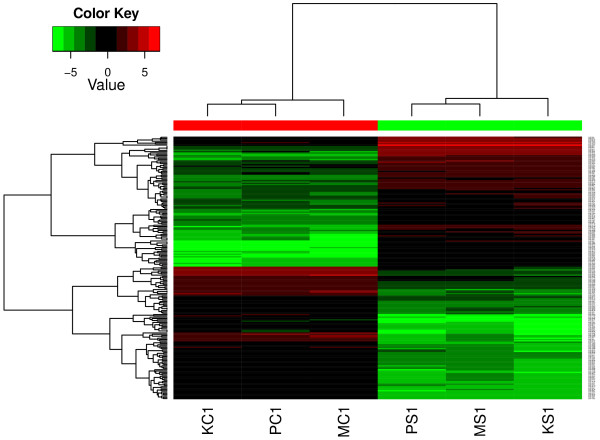
Heatmap showing differential expression of top 200 genes between control (C1) and stress (S1) treatments. Dark shades indicate higher expression and light shades indicate lower expression. Color key indicates the intensity associated with normalized expression values. Abbreviations as in Figure 2.